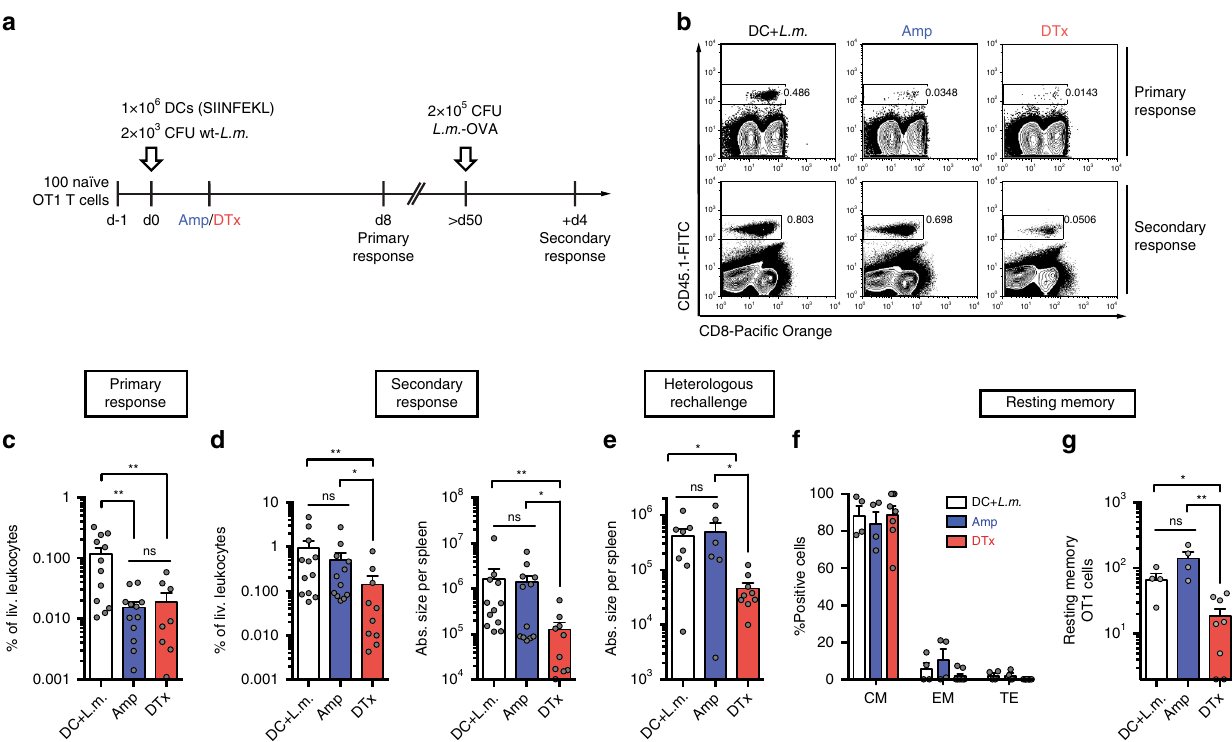
Fig. 6 Sustained antigen availability during priming, but not in fl ammation supports strong memory CD8 + T cell responses. a C57BL/6 mice received 100 naïve OT1 cells and were immunized with DC + L.m . Mice then either received Amp at 24 h ( n = 12), DTx at 48 h ( n = 10), or were left untreated (DC + L.m .; n = 12). Progeny were screened in peripheral blood at day 8 and then longitudinally analysed 4 days after a rechallenge infection with recombinant L.m .-OVA. b Representative contour plots showing the percentage of transferred T cells among living leukocytes during the primary (upper row) and secondary immune response (lower row). c Bar graph depicts the percentage of transferred T cells among living leukocytes at day 8 (DTx: n = 2 progenies initially not detected). d Bar graphs depict the percentage of transferred T cells among living leukocytes (left) and absolute number of daughter cells in spleen (right) at day 4 after L.m .-OVA rechallenge. e As in d , but after heterologous MVA-OVA vaccination (DC + L.m . n = 8; Amp n = 6; DTx n = 9). f Bar graph indicates the percentage of resting memory T cells (no rechallenge) of central memory (CM), effector memory (EM) or TE phenotype, at 6 weeks post immunization (DC + L.m . n = 4; Amp n = 4; DTx n = 8). g Bar graph indicates corresponding numbers of resting memory T cells in spleen and lymph nodes. Lines depict the mean, error bars the s.e.m. * P < 0.05, ** P < 0.01 (Mann – Whitney test). Data are compiled from two independent experiments. Source data are provided as a Source Data fi